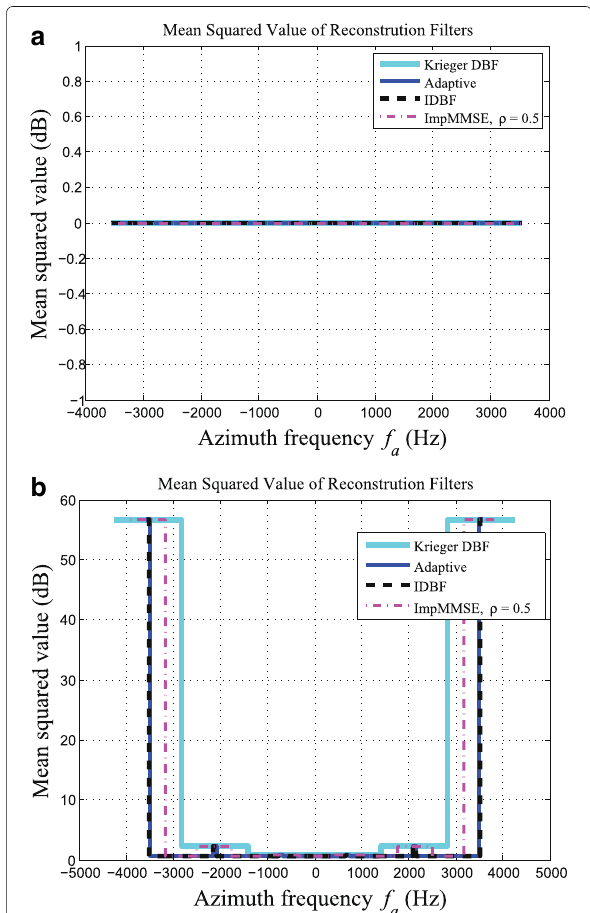
Fig. 6 Aliasing number N and relative resolution degradation. a Aliasing number obtained by different reconstruction methods against the uniformity of azimuth sampling κ . b Relative resolution